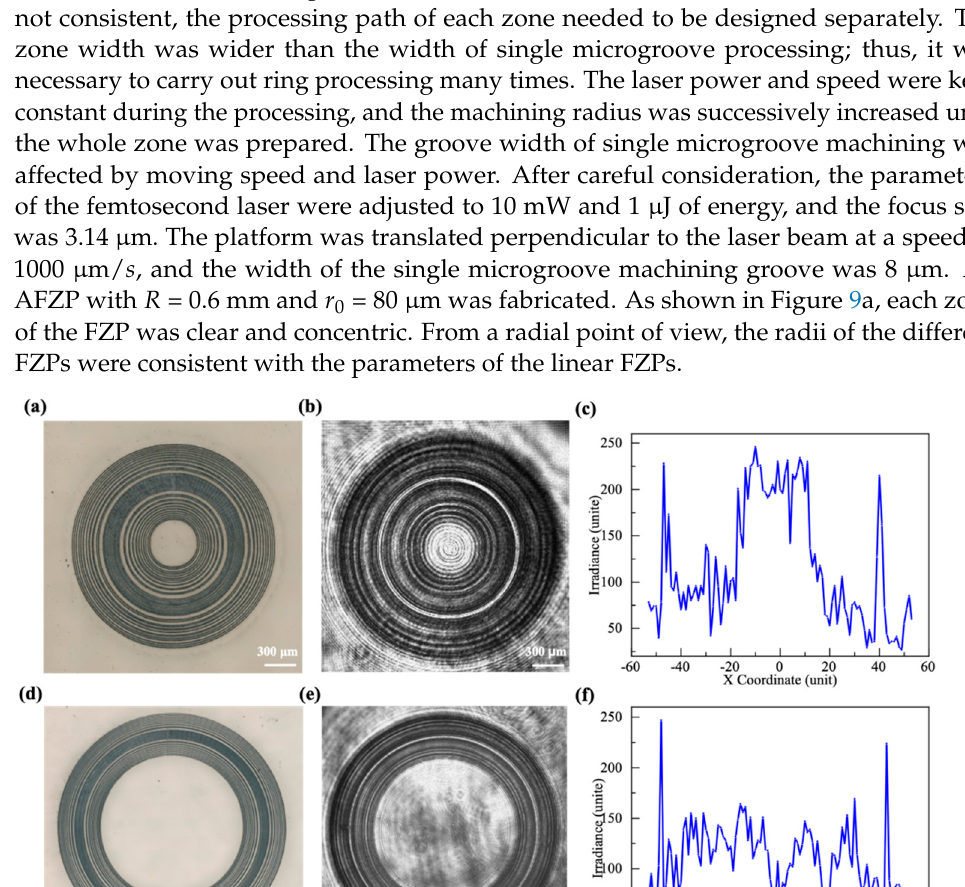
Figure 10. Schematic diagram of double-ring AFZP. A double-ring AFZP with 𝑟 (cid:2868) = 80 μ m, 𝑅 (cid:2869) = 1.6 mm, and 𝑅 (cid:2870) = 2.4 mm was simu- lated. As shown in Figure 11a, two clear concentric rings appeared in the focal plane with no spot at the center, and the spacing 𝑅 (cid:3031) between the two rings was 0.8 mm. For multi-